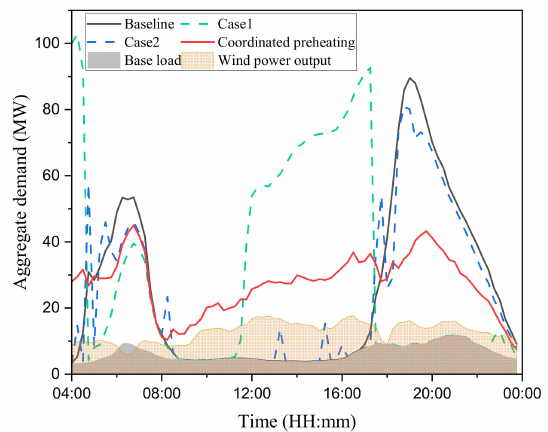
Figure 8. Total load under different